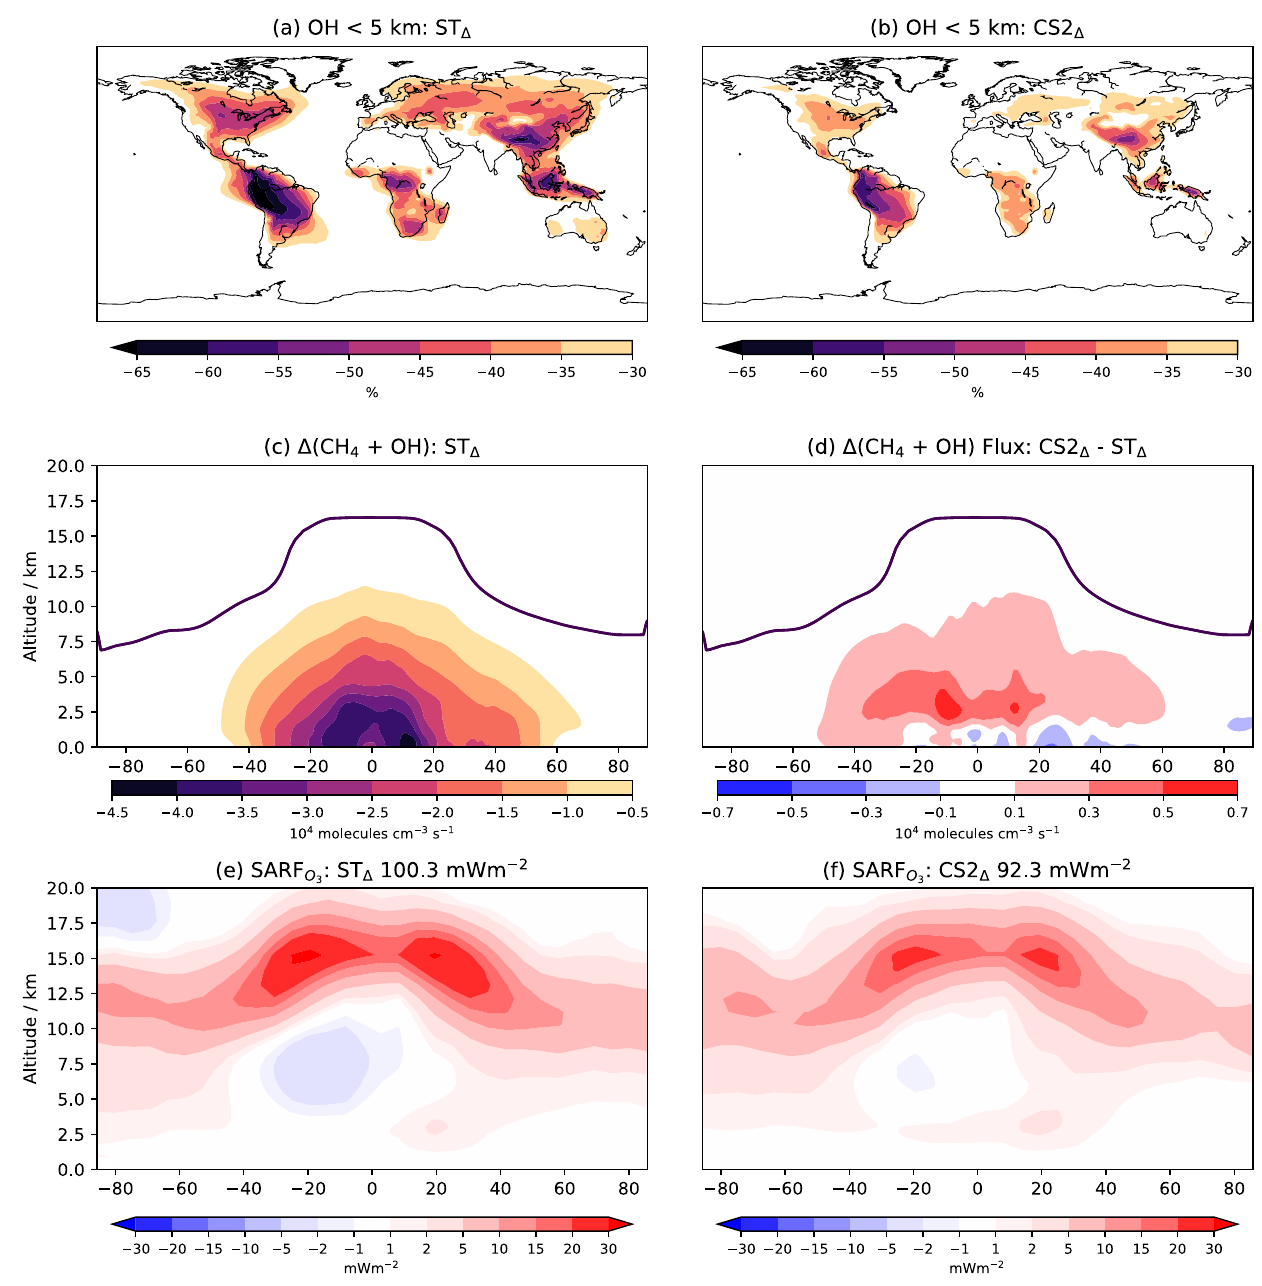
Fig. 3 | OH, CH 4 oxidation and O 3 radiative forcing. Percentage change in OH in lowest 5km for ( a ) Strat-Trop (ST Δ ) and ( b ) CRI-Strat 2 (CS2 Δ ).Zonal mean change